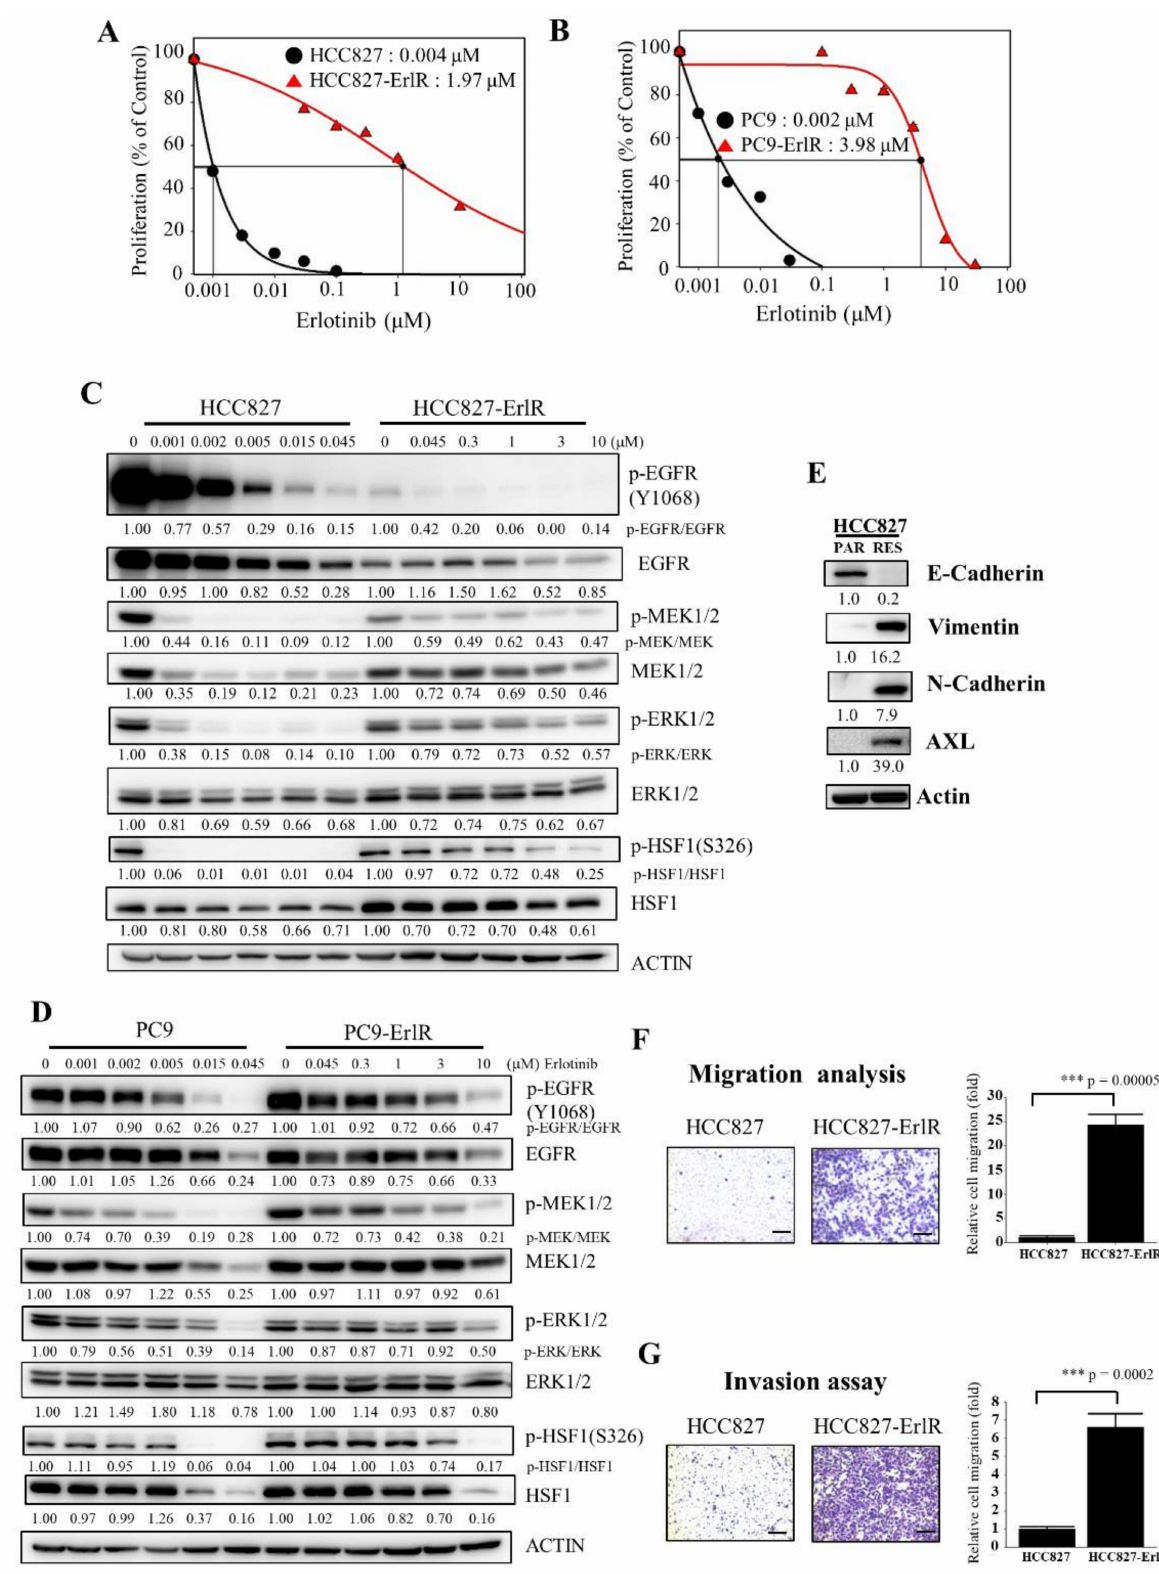
Figure 1. Generation and characterization of erlotinib-resistant NSCLC cancer cell lines. ( A , B ) HCC827, HCC827-ErlR, PC9, and PC9-ErlR cells were treated with 0.1% DMSO or different concentrations of erlotinib. After incubation for 72 h, cells